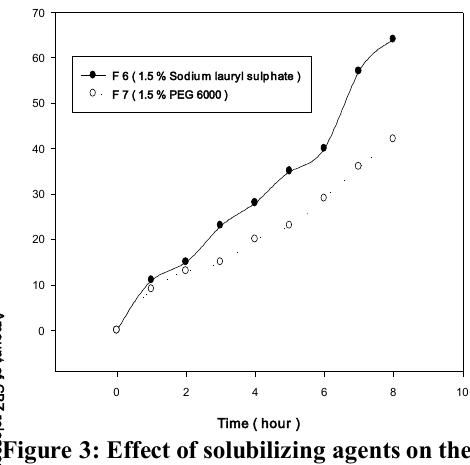
Figure 3: Effect of solubilizing agents on the release of CBZ from ethyl cellulose